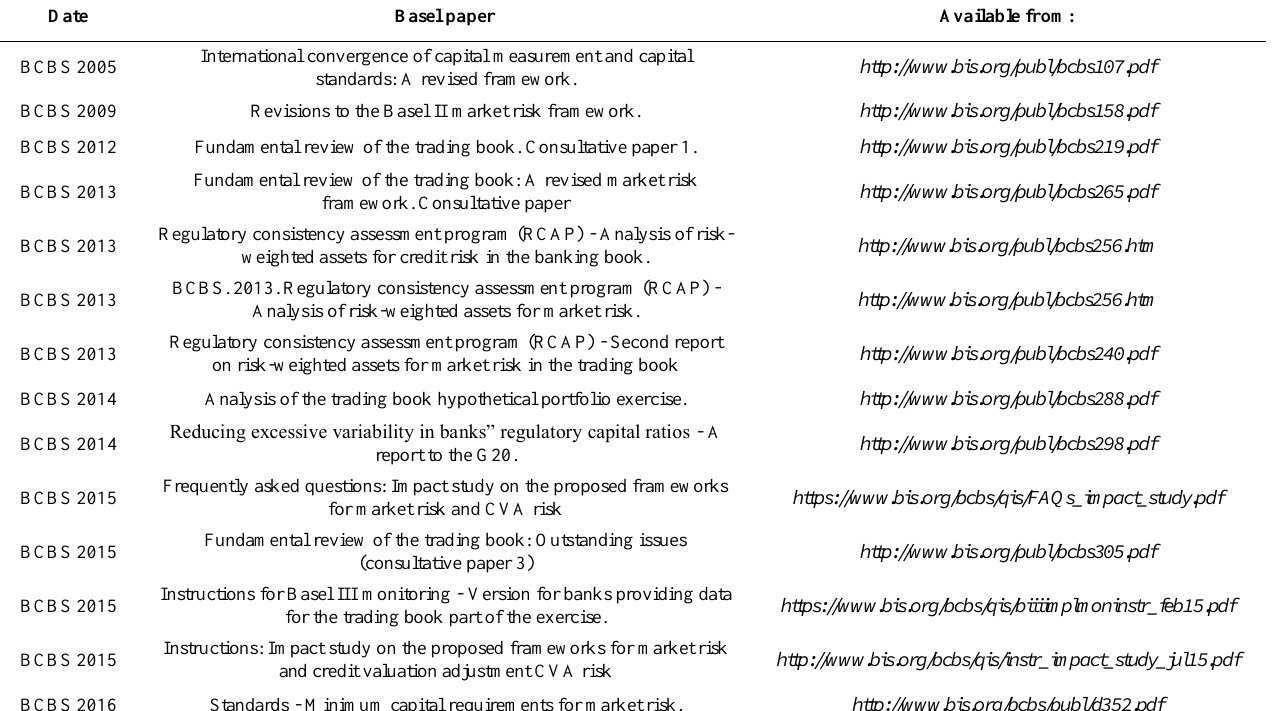
Table 2. Overview of the